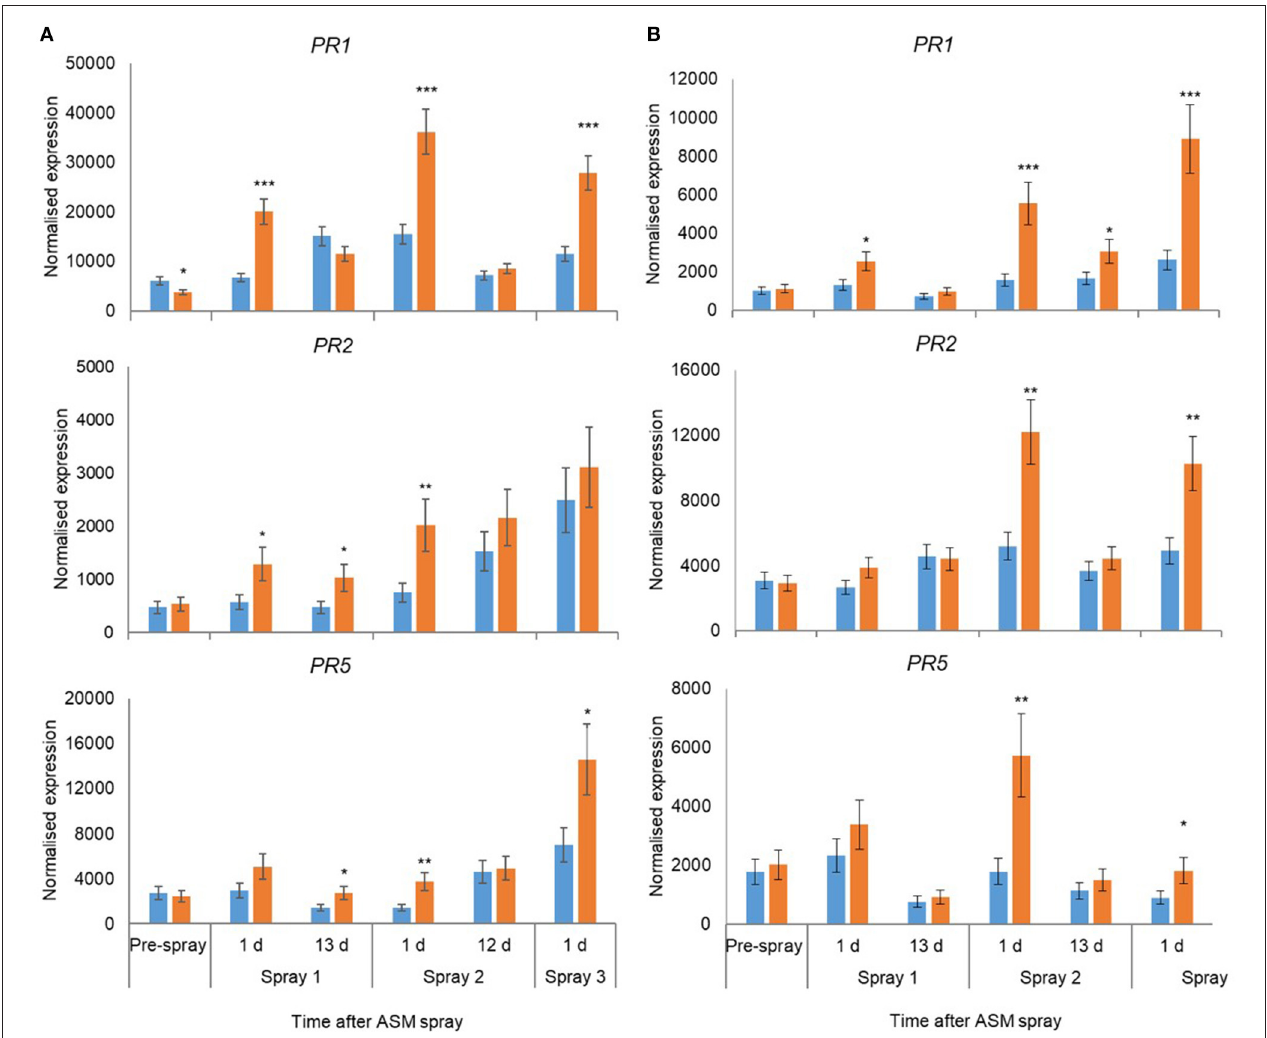
FIGURE 4 | Expression of PR1, PR2, and PR5 in leaves of Actinidia chinensis var. deliciosa ‘Hayward’ (A) and A. chinensis var. chinensis ‘Zesy002’ (B) vines at different times after Actigard (ASM) application during spring in 2018. Actigard (ASM) was sprayed on ‘Zesy002’ on 27 September, 10 October, and 24 October, and on ‘Hayward’ on 16 October, 31 October, and 13 November. Gene expression was measured by PlexSet ® NanoString where the Y-axis represents physical counts of the number of molecules expressed. Data were normalised against six references genes— 40s rRNA , actin , elongation factor , glyceraldehyde 3-phosphate dehydrogenase , protein phosphatase 2A , and ubiquitin-conjugating enzyme . Data were log 2 transformed for analysis, but are presented as back-transformed means. Asterisks above bars indicate significant treatment differences, where * < 0.05, ** < 0.01, and *** <